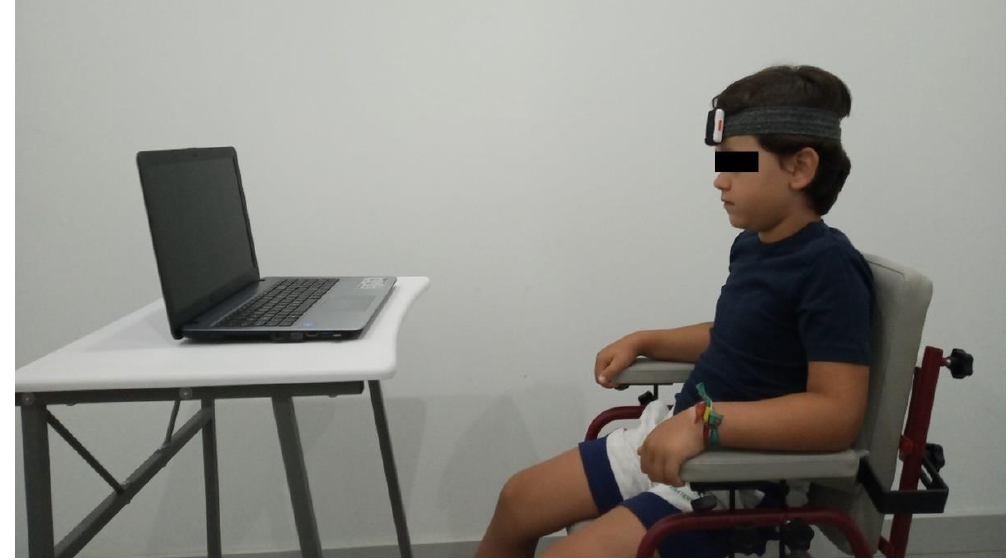
Figure 1. Inertial measurement unit (IMU) test application: sensor, subject, and laptop location.